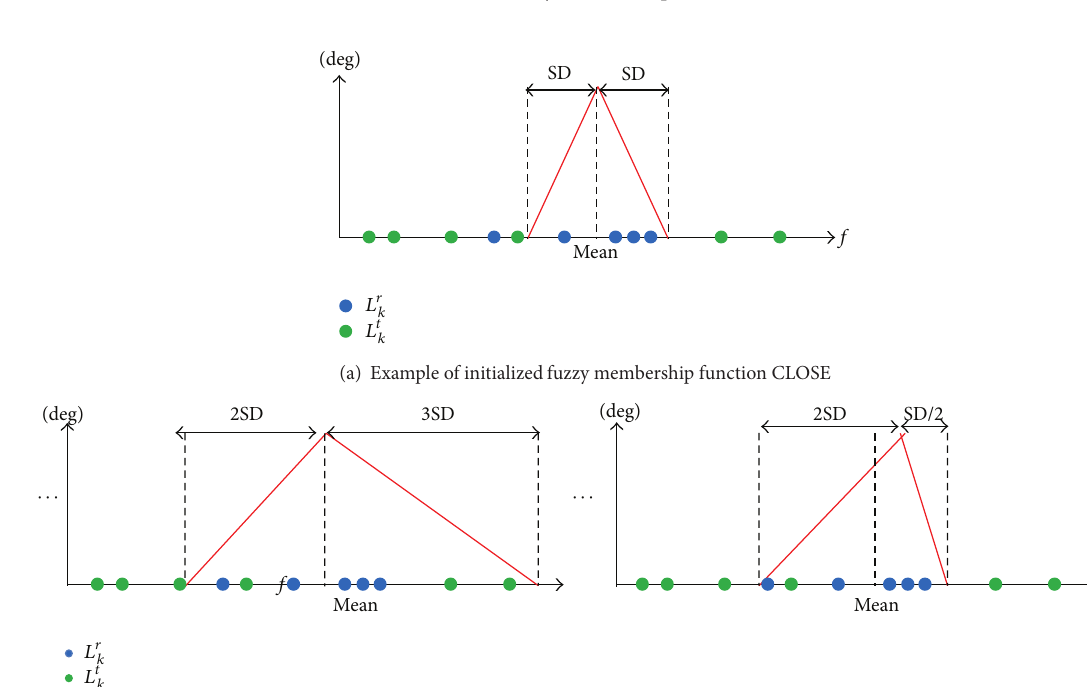
Figure 12: Fuzzy membership functions.